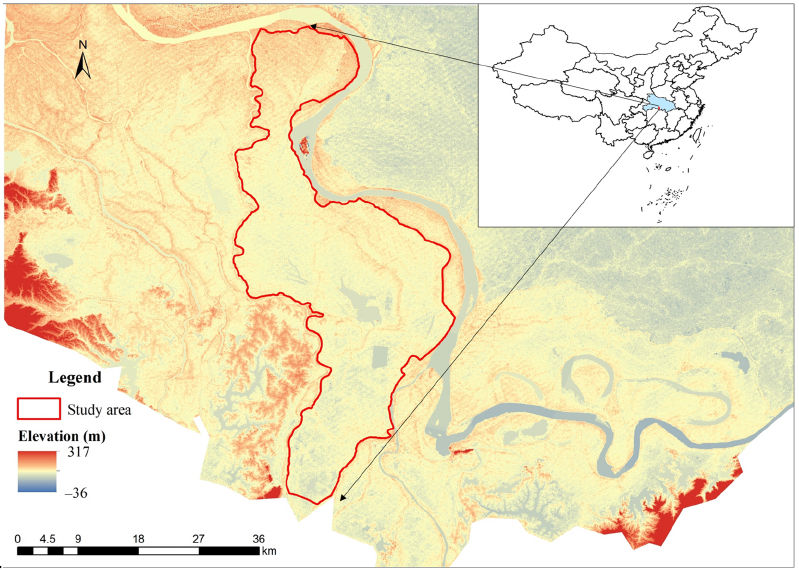
Figure 7. Location of the study area (JFDD), which is located in Hubei province (the light blue area on the map of China) and along the Yangtze River. The reference coordinate system is WGS84.